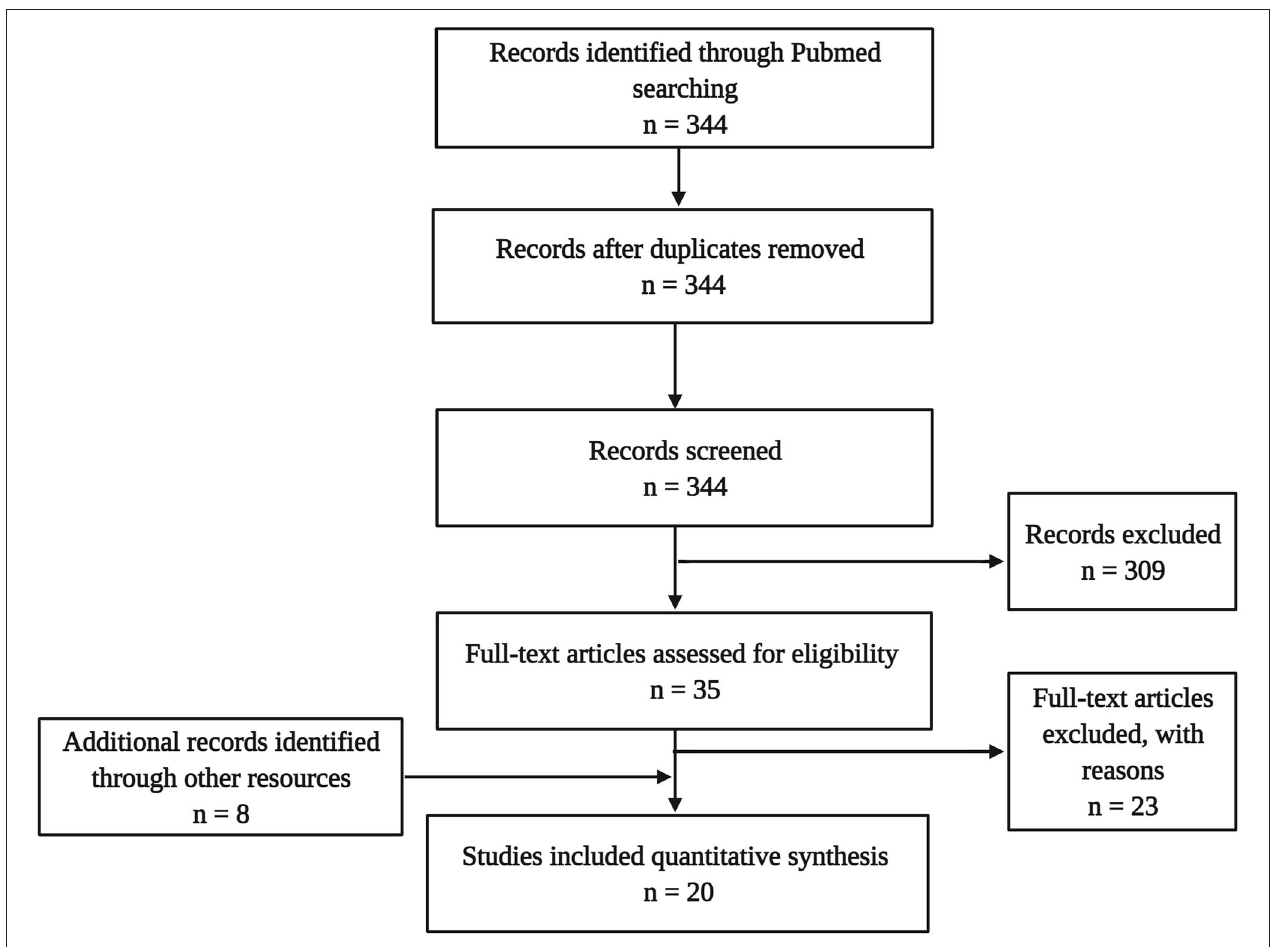
FIGURE 3 | Flow diagram illustrating the selection and review processes of the systematic